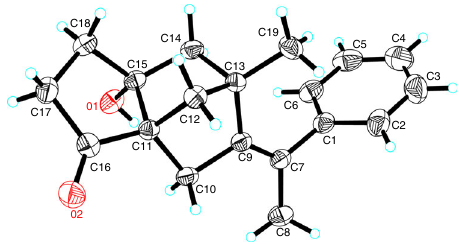
Fig. 3 Absolute con fi guration. ORTEP representation of the product